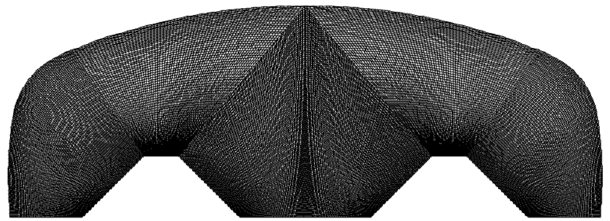
Figure 2. Diagram of mesh distribution.